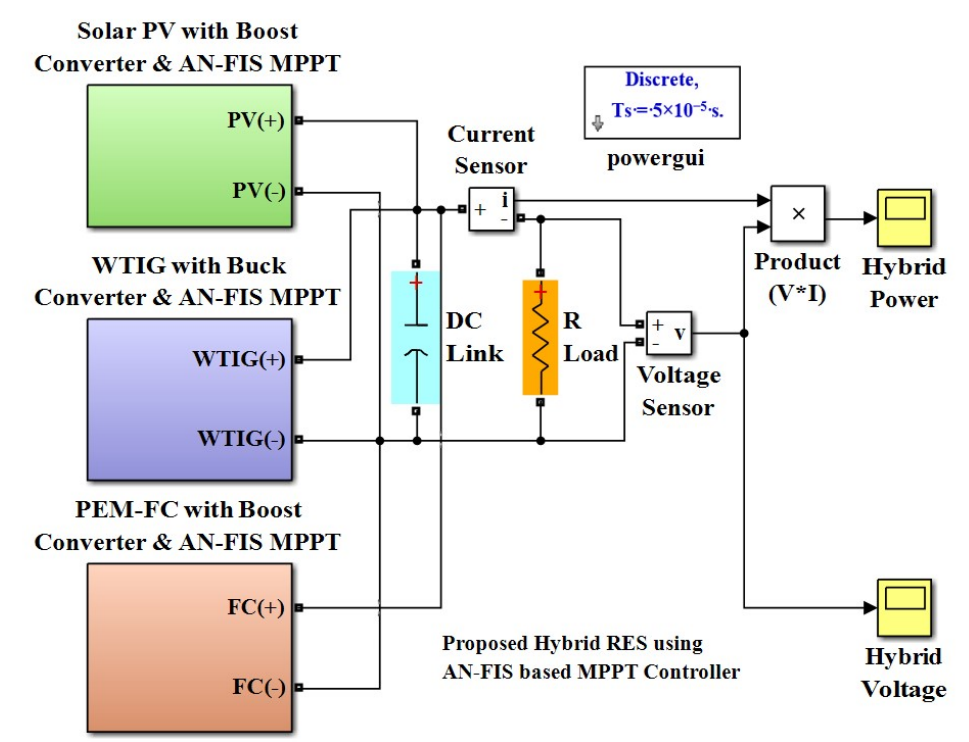
Figure 30. Modelling of Proposed Hybrid RES with AN-FIS MPPT.